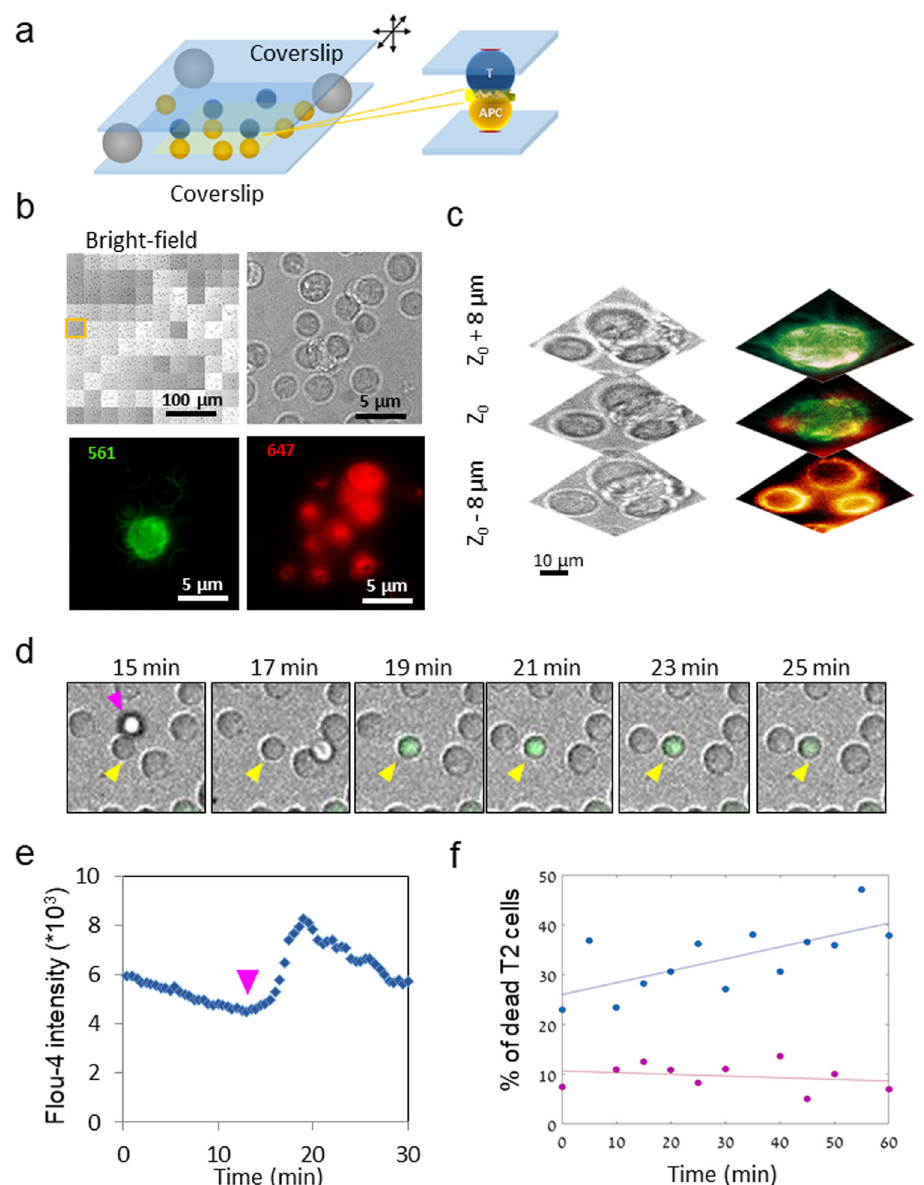
Fig. 1 Microscopy of T/APC conjugates on opposing surfaces. a A schematic description of imaging T/APC conjugates on opposing coverslips. b Large- scale microscopy images consisting of 100 fi elds of view were taken of CD8 + T cells in contact with APC (T2 hybridoma) cells loaded with the activating peptide NY-ESO-1. A montage of large-scale bright- fi led images and a single fi eld is shown (top row). Image contrast of these images was adapted here for improved visibility of single cells. The PM of the CD8 + T cells was stained for α CD45 and Alexa647 (red) and the PM the T2 cells was stained using DPEE- Atto565 (green). Fluorescence images of the zoom fi eld are shown (bottom row). Large-scale images in bright fi eld, and in each of the fl uorescence channels were routinely collected at different z-sections and are shown in Fig. S1. c Zoomed bright fi eld and fl uorescence images from the single fi eld in panel b are shown at different heights (focal planes) relative to the cell interface. d Calcium imaging of Fluo-4 stained live CD8 + T cells (yellow arrowhead), upon encounter with the T2 cells (magenta arrowhead) loaded with the activating peptide NY-ESO-1. A representative fi eld is shown. Yellow arrowheads show an activated cell of interest. e The intensity time-trajectory of Fluo-4 in the pointed CD8 + T cell in panel d . Magenta arrowhead indicates the time of the cell engagement with the T2 APC. f The time-dependent killing ef fi ciency by CD8 + T cells of the T2 cells, with (blue) or without (magenta) loading with NY-ESO-1 bottom surface spherical silicon beads of a desired size that matches the length of the cell – cell conjugate. Synchronization of cell – cell encounter is primarily achieved by timing the placement of the surfaces, one on top of the other. Further synchronization can be achieved by sliding one of the opposing coverslips (typi- cally, the top coverslip in an inverted microscope) relative to the other (see Methods). The spherical beads ensure that the cover- slips remain perfectly parallel during this motion.